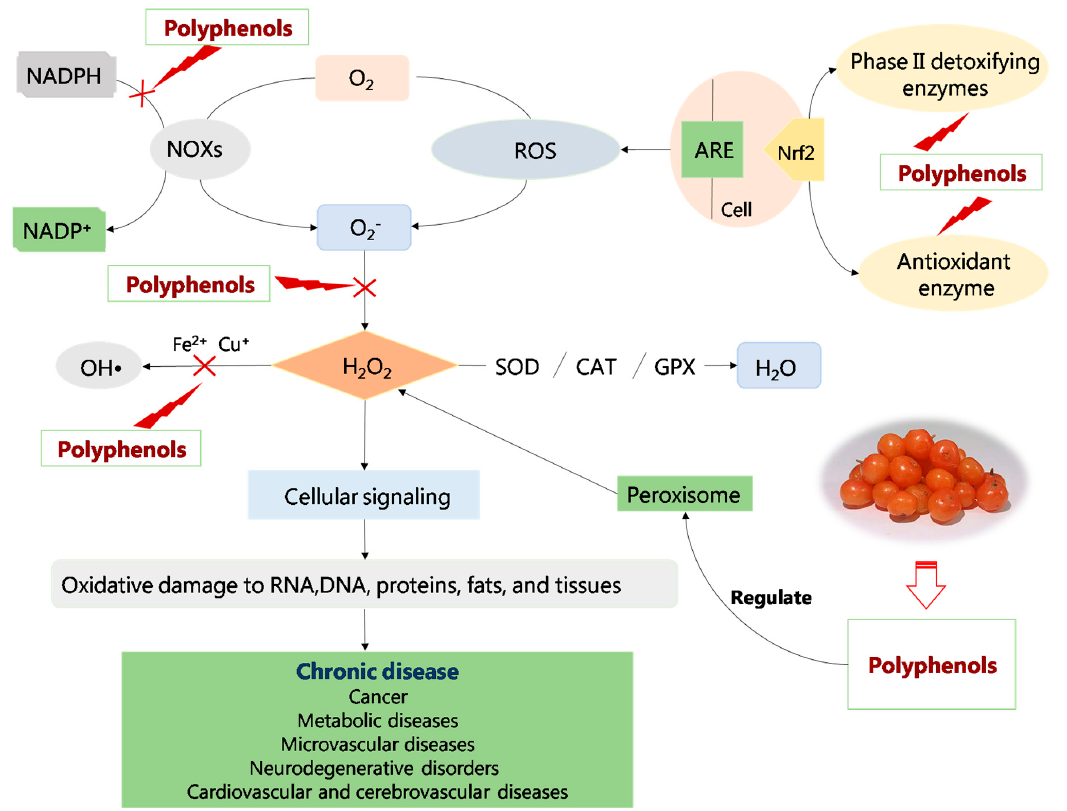
Figure 7. The antioxidant mechanism of polyphenols from Hippophae species. (NADPH: nicotinamide adenine dinucleotide phosphate; NADP + : nicotinamide adenine dinucleotide phosphate; NOXs: NADPH oxidases; SOD: superoxide dismutase; CAT: catalase; GPX: glutathione